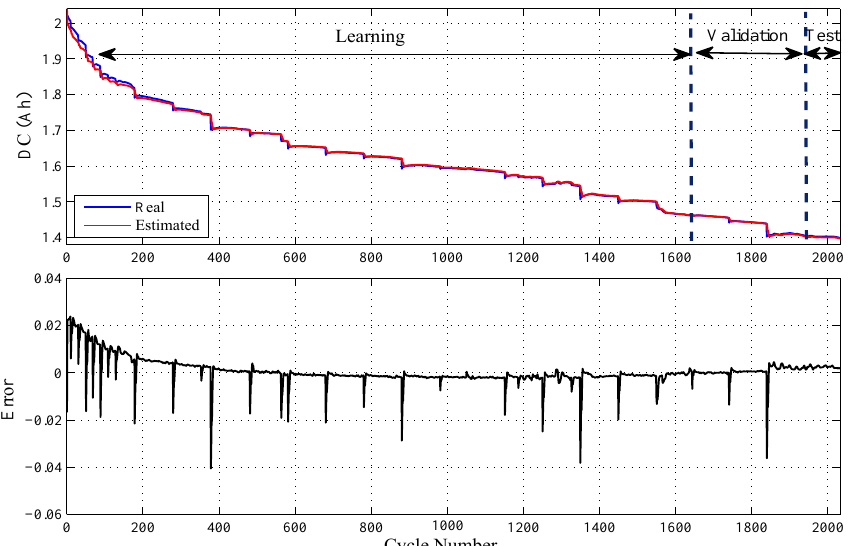
Figure 8. Evolution of real and estimated DCs of the LM-BPNN algorithm.